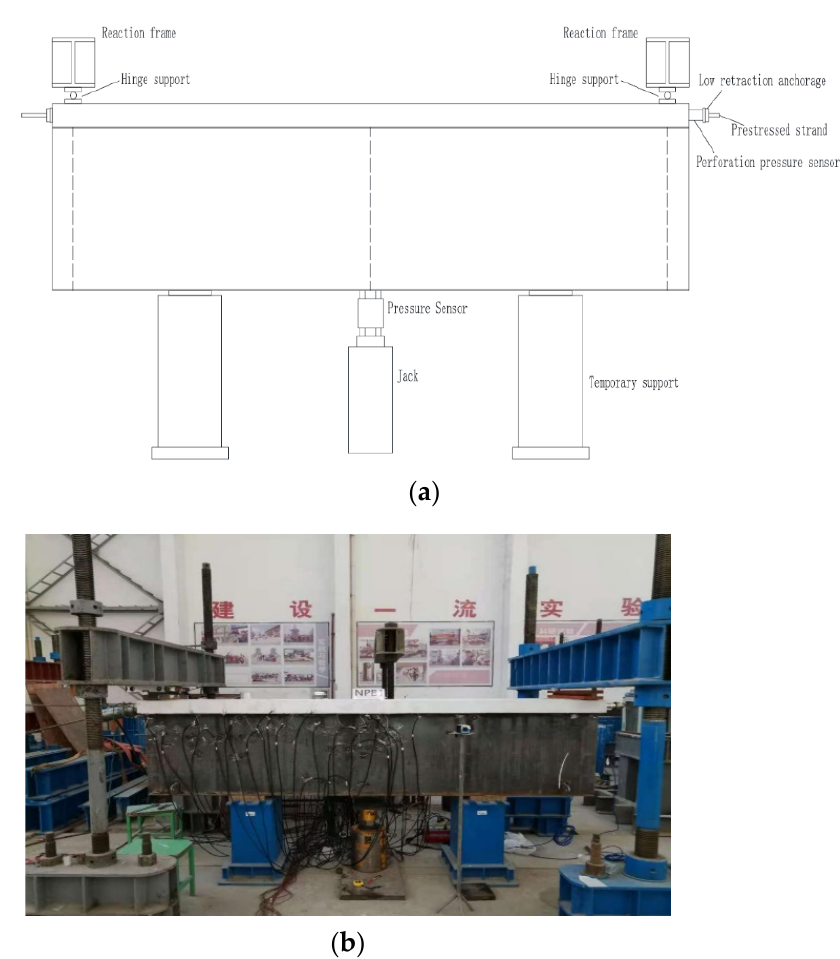
Figure 4. Experimental loading device. ( a ) Loading arrangement, ( b ) Field loading diagram.